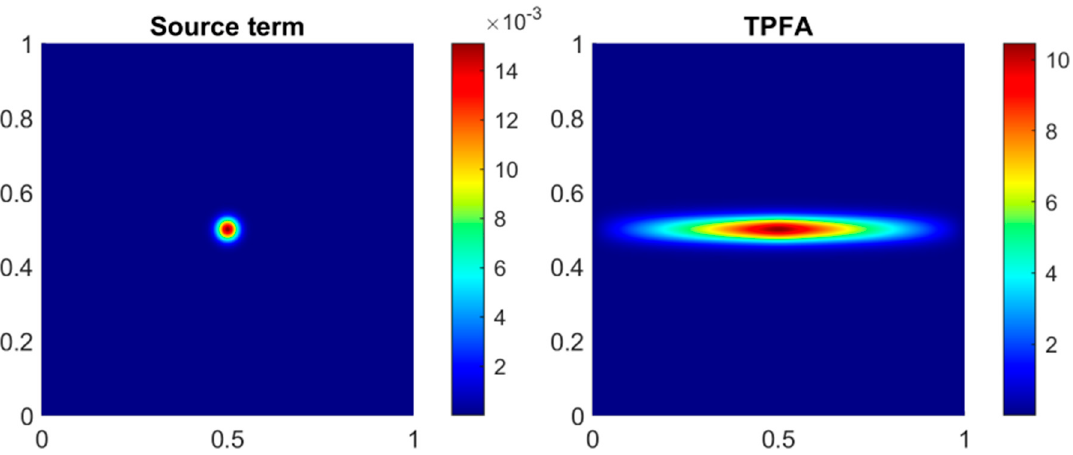
Figure 2. Source function ( left ) and pressure solution using TPFA ( right ) for case 1: 𝜃 = 0.